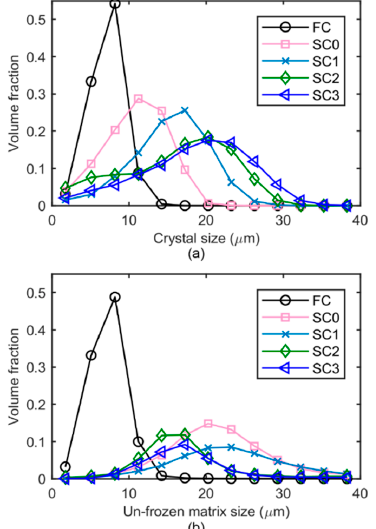
Figure 7. The size distributions of ( a ) the ice crystals and ( b ) the unfrozen matrix in the ice cream sample after fast cooling to 250 K (FC), and then after the fast reheating and holding process at 266.8 K (SC0), and during the slow cooling process at 263.4 K (SC1), 260.8 K (SC2), and 250 K (SC3), respectively.